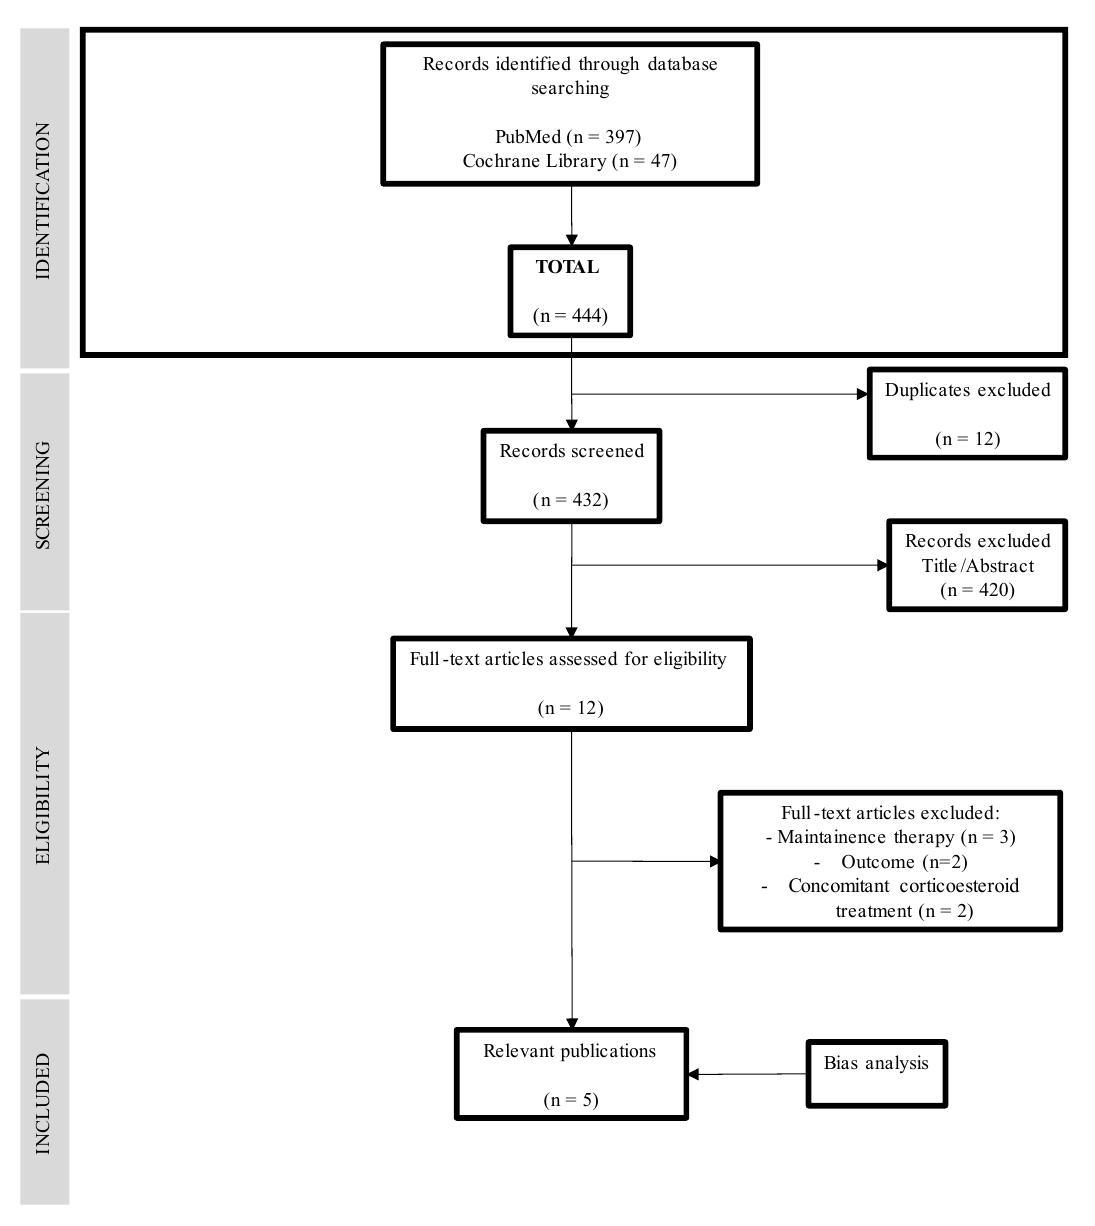
Figure 1. Flowchart of the search strategy and results. Table 2. Inclusion and exclusion criteria of the included